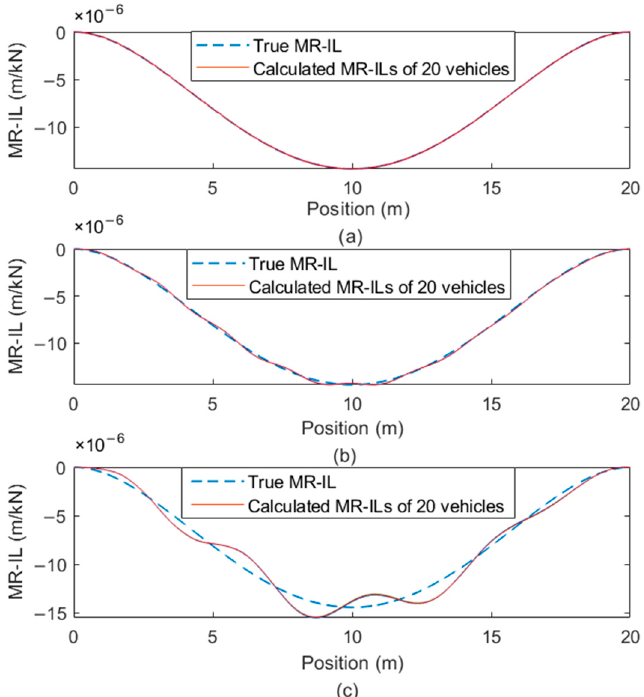
Figure 7. True and calculated fundamental MR-ILs for bridge and vehicle at different speeds: ( a ) 2 m/s; ( b ) 10 m/s; ( c ) 20 m/s.